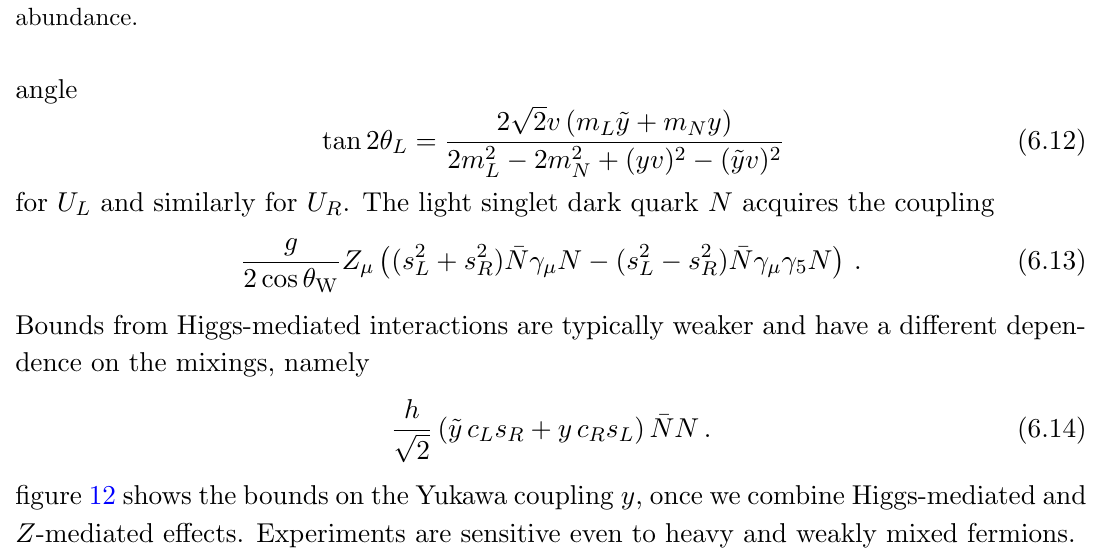
Left: thermally = 10 TeV Q